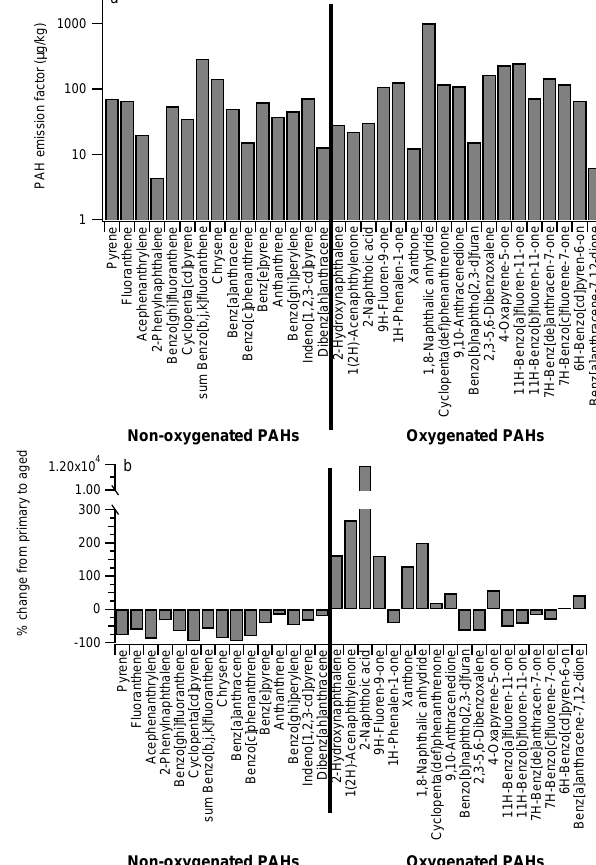
Figure 4. Average (a) PAH emission factor and (b) percent change between primary and aged filter samples for each compound quan- titatively measured during filter analysis for high-load